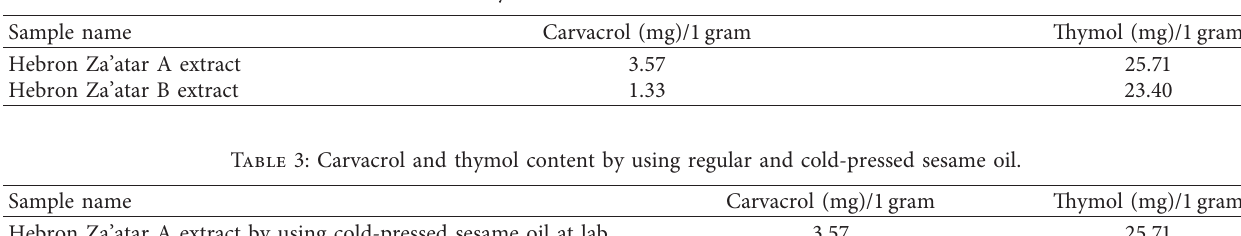
Table 2: Carvacrol and thymol content in different locations of Hebron Za’atar.